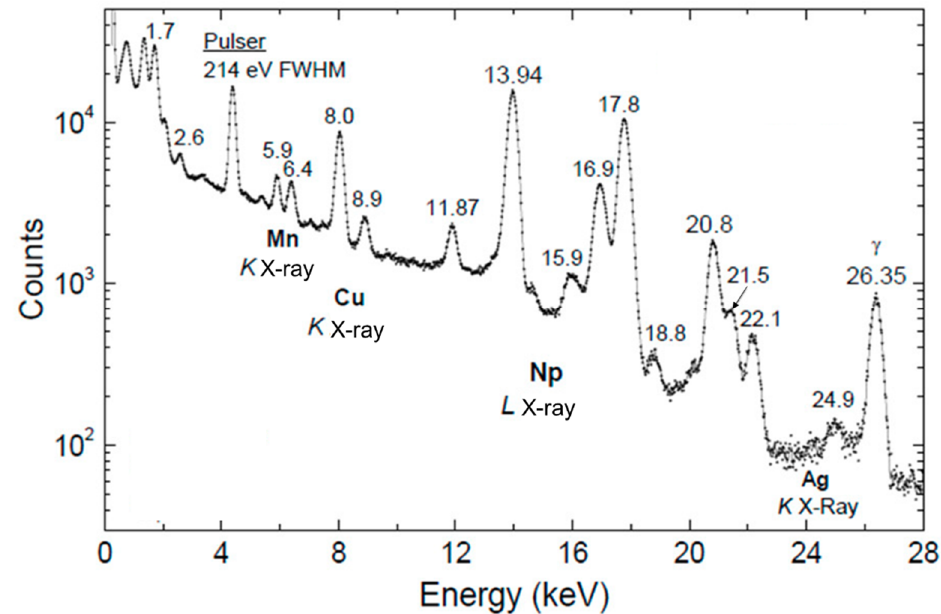
Figure 10. X-ray spectrum from a 241 Am source measured at RT using a SiC detector in the energy range 0 to 28 keV. Data were taken from Ref. [12] .